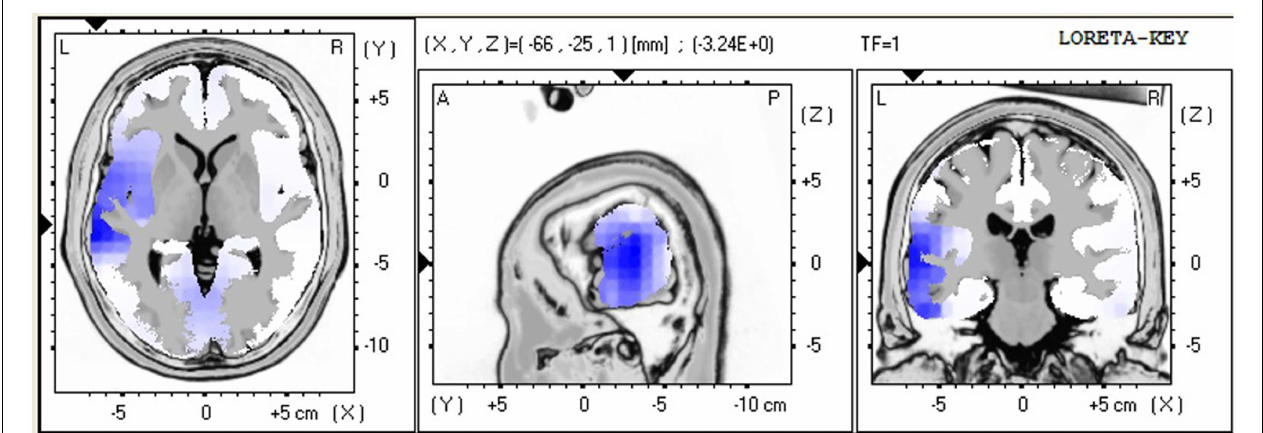
FIGURE 4 | LORETA non-parametric voxel-wise comparison maps betweenALS and control groups in the P2 time window . Blue: significantly lower activity in ALS.